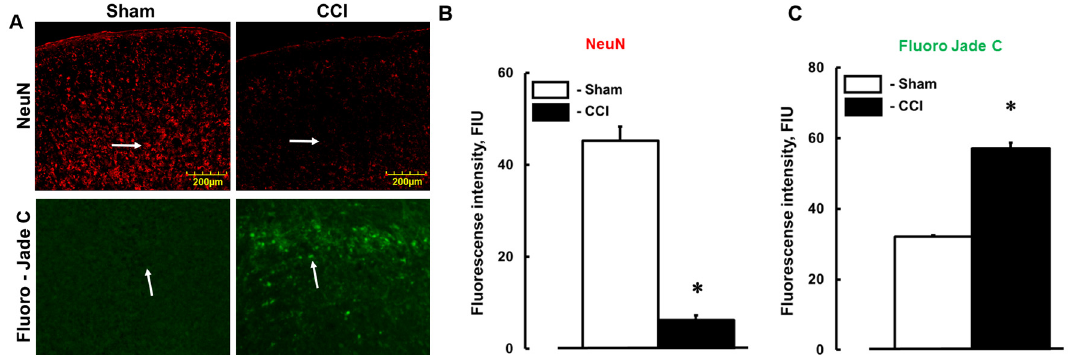
Figure 3. Neuronal degeneration 14 days after cortical contusion injury (CCI) in mice ( A ) Examples of expression of neuronal marker NeuN (red, upper row) and marker of damaged neurons Fluoro ‐ Jade C (green, lower row) in mouse brain samples collected 14 days after sham ‐ operation (sham) and CCI. Summary of ( B ) NeuN and ( C ) Fluoro ‐ Jade C expressions assessed as a measure of their fluorescence intensity in brain samples and presented as fluorescence intensity units (FIU). * p < 0.05 vs. WT. n = 6. DR that was defined by NORT was lower in mice with CCI than in the control group (Figure 4A). DI and Spontaneous alternation that were detected with Y-maze tests were also lower in animals with injury than in sham-operated mice (Figure 4B,C,